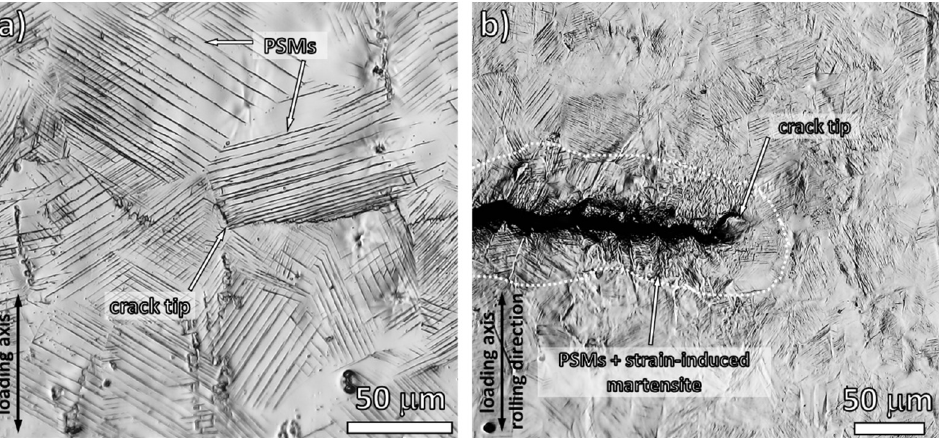
Figure 6. Detail of the crack tip vicinity: ( a ) Sanicro 25—distinct planar character of cyclic plastic deformation; ( b ) 304L—slip plane markings accompanied with significant surface roughness indicating the occurrence of the strain-induced martensitic transformation (SIMT) within crack plastic zone.